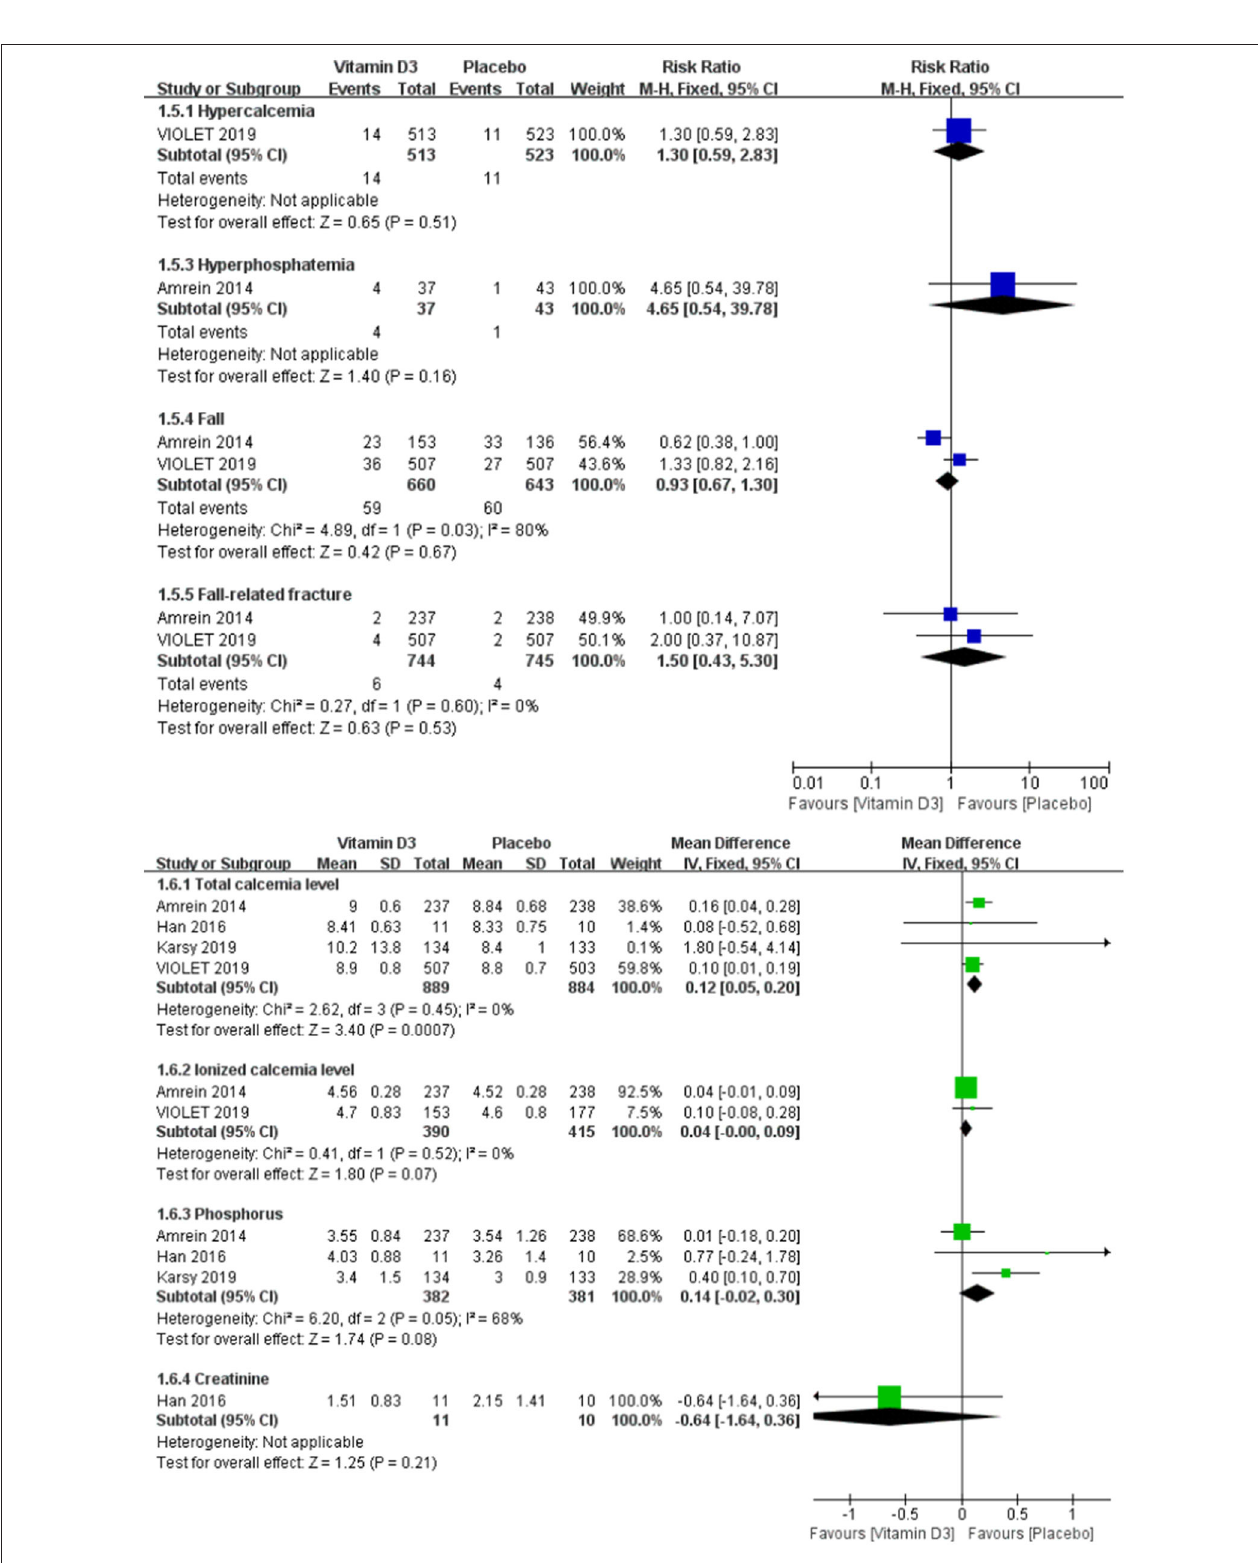
FIGURE 4 | Forest plots of adverse events between the vitamin D3 group and the placebo group in critically ill adult patients.